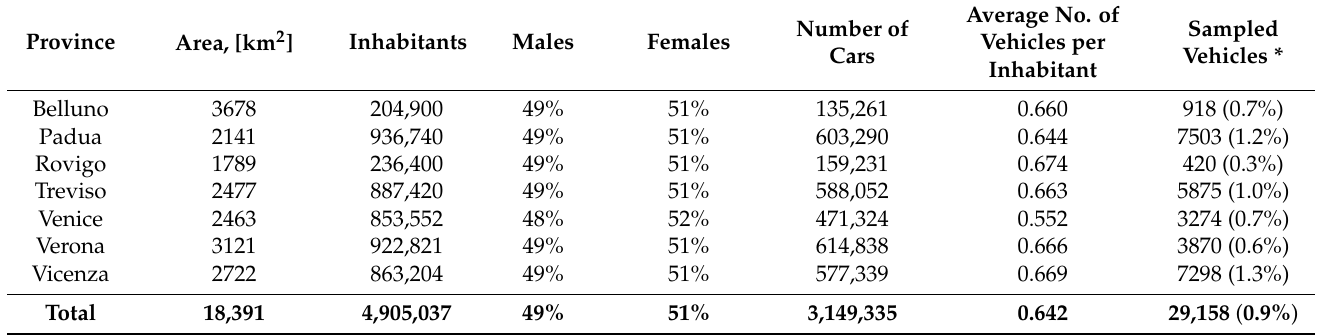
Table 1. Statistical data for the Veneto